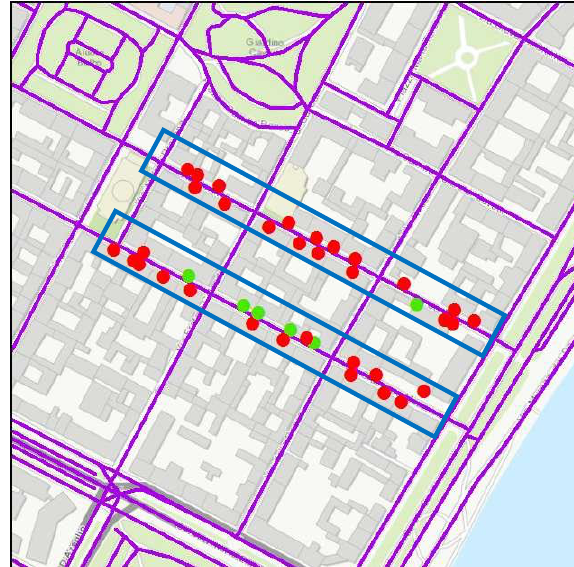
Figure 14. “PASSO CARRABILE” traffic signs in the test area (blue rectangle): actual positions (red dots) vs Mapillary detections (green